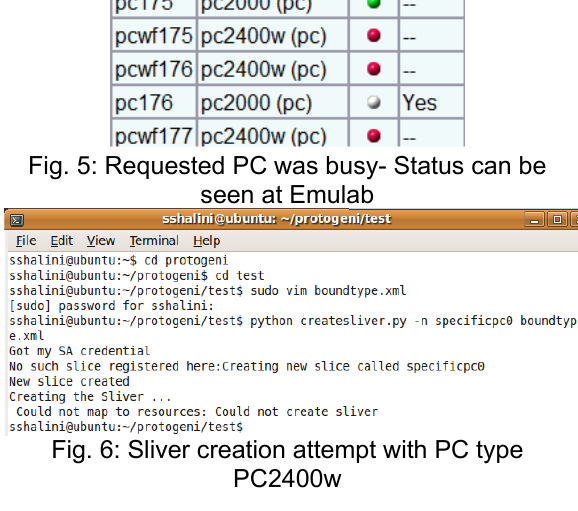
Fig. 6: Sliver creation attempt with PC type